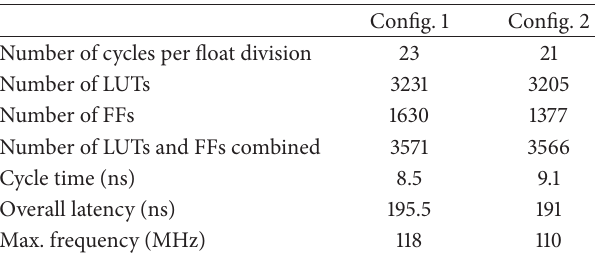
Table 6: Postplace and route result of the floating-point divider based on type2.